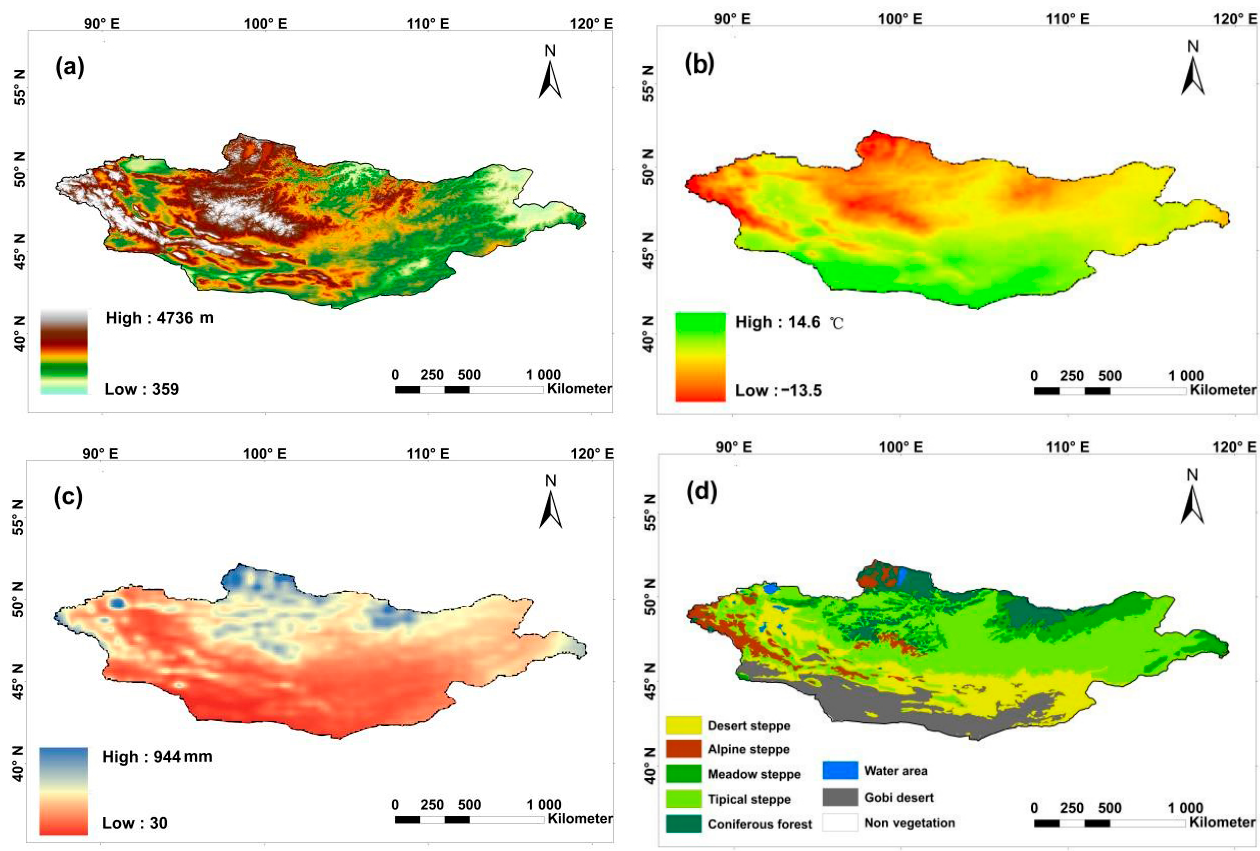
Figure 1. Spatial distributions of the elevation ( a ), temperature ( b ), precipitation ( c ) and vegetation type ( d ) in Mongolia. type ( d ) in